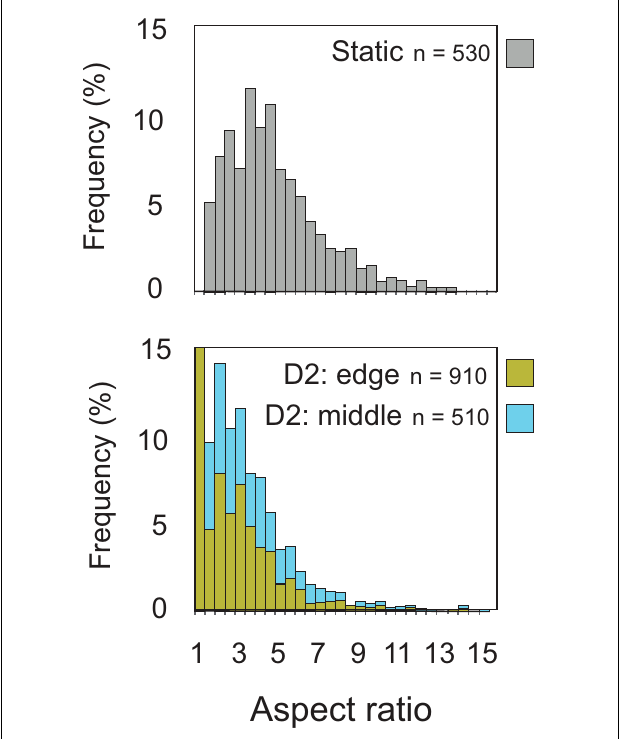
FIGURE 3 | Frequencies of microlite aspect ratios. Histograms of aspect ratios from static experiments (3SP350-10 and 12SP350-10, gray bars) are compared with those found in a D2 experiment (9SP350-10, stacked yellow and blue bars). Yellow bars represent aspect ratios measured within 10’s of microns from the capsule-magma interface. Blue bars represent aspect ratios measured in images collected from the interior of the quenched experiment. An increase in the relative frequency of equant, lower aspect ratio microlites was found in the experiment that underwent a second decompression. Critically, the smallest aspect ratios were found along the capsule walls (yellow bars, D2–edge) vs. the middle (blue bars, D2–middle).